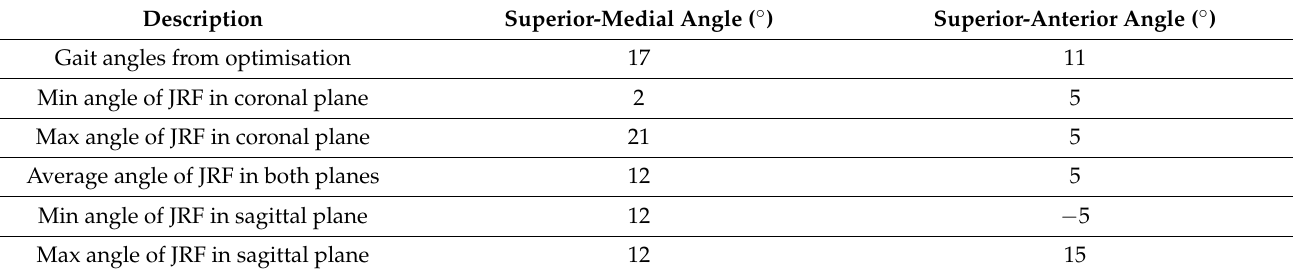
Table 2. Summary of the loading directions simulated strain shielding tests. The top row is equivalent to the peak gait loading angle used during the optimisation process. The other rows represent typical variations in the direction of the joint reaction force during activities of daily